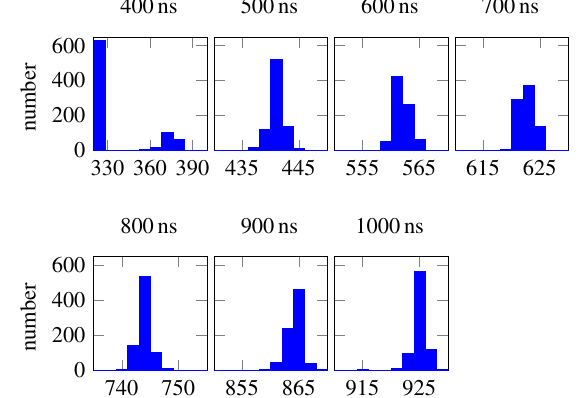
FIG. 10. Histogram of observed electron bunch lengths (in ns), one plot per setting. Due to a deficiency of the circuit triggering the grid pulser, the central values of the distributions differ from the set point by varying amounts. In the 400 ns case, two different bunch lengths are created.